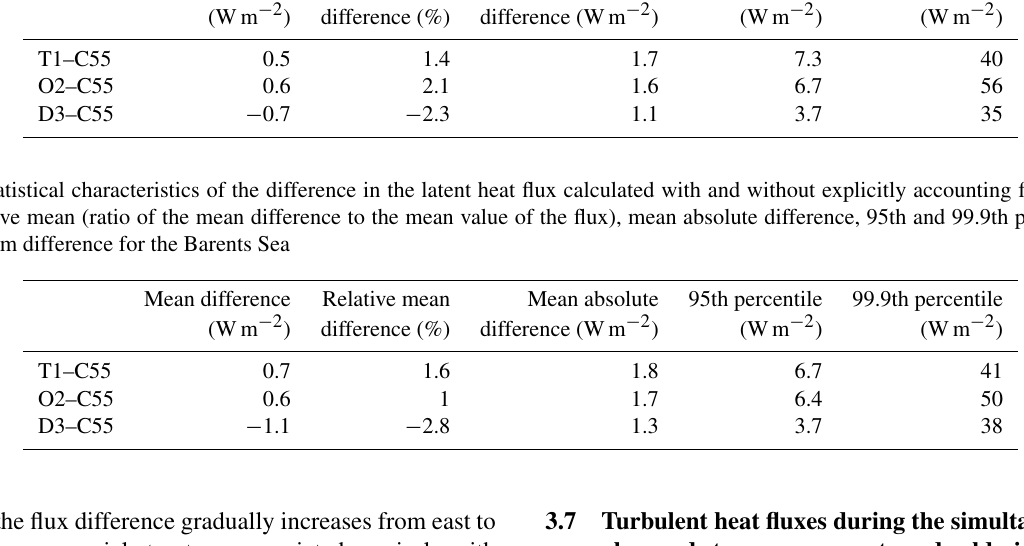
Table 1. Statistical characteristics of the difference in the sensible heat flux calculated with and without explicitly accounting for sea wave parameters: mean difference, relative mean (ratio of the mean difference to the mean value of the flux), mean absolute difference, 95th and 99.9th percentile, and the maximum difference for the Barents Sea Mean difference Relative mean Mean absolute